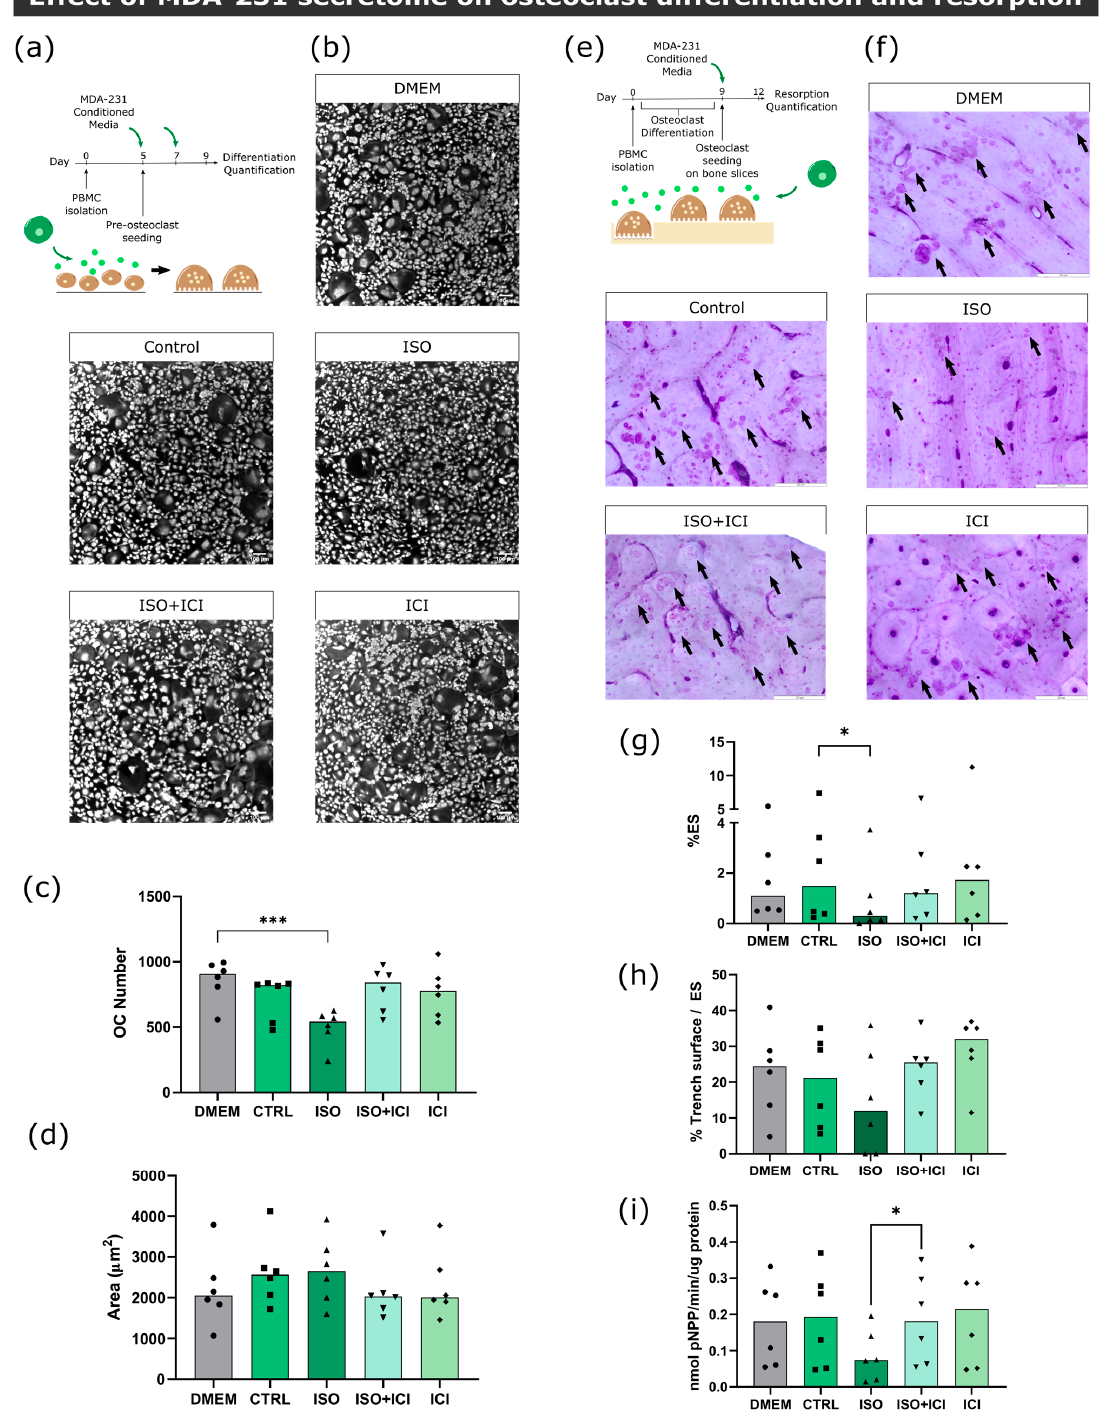
Figure 3. Effect of MDA-231 conditioned medium on osteoclast differentiation and resorption activity. ( a ) Timeline of the osteoclast differentiation assay. Pre-osteoclasts are seeded after five days of culturing and stimulated with MDA-231 cell-conditioned media for four more days, changing the media at day 7. ( b ) Representative micrographs of differentiated osteoclasts were stained with HCS CellMask Deep Red Stain. Scale bar—100 µ M. ( c ) Osteoclast number and ( d ) area after four days of MDA-231-conditioned media stimulation. Osteoclasts with three or more nuclei were included in the analysis. Data are expressed as the median of individual data points from six